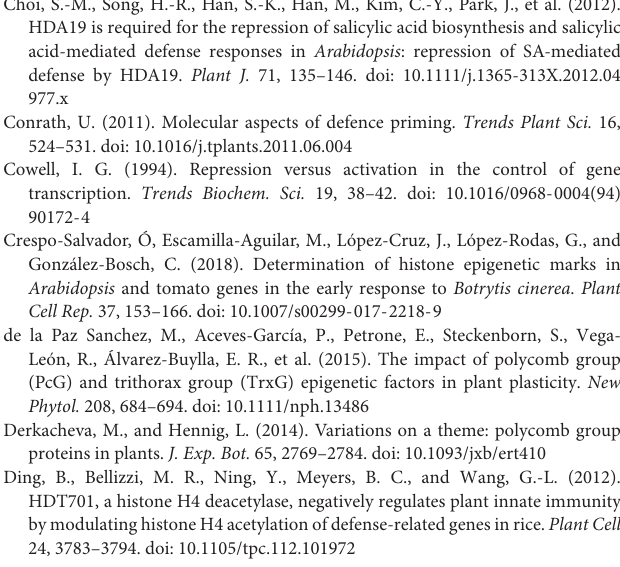
FIGURE S4 | Transcript levels of genes modifying histone methylation – TrxG (A) , SUVH4 (B) , and demethylation JMJ706 (C) in primed potato progeny